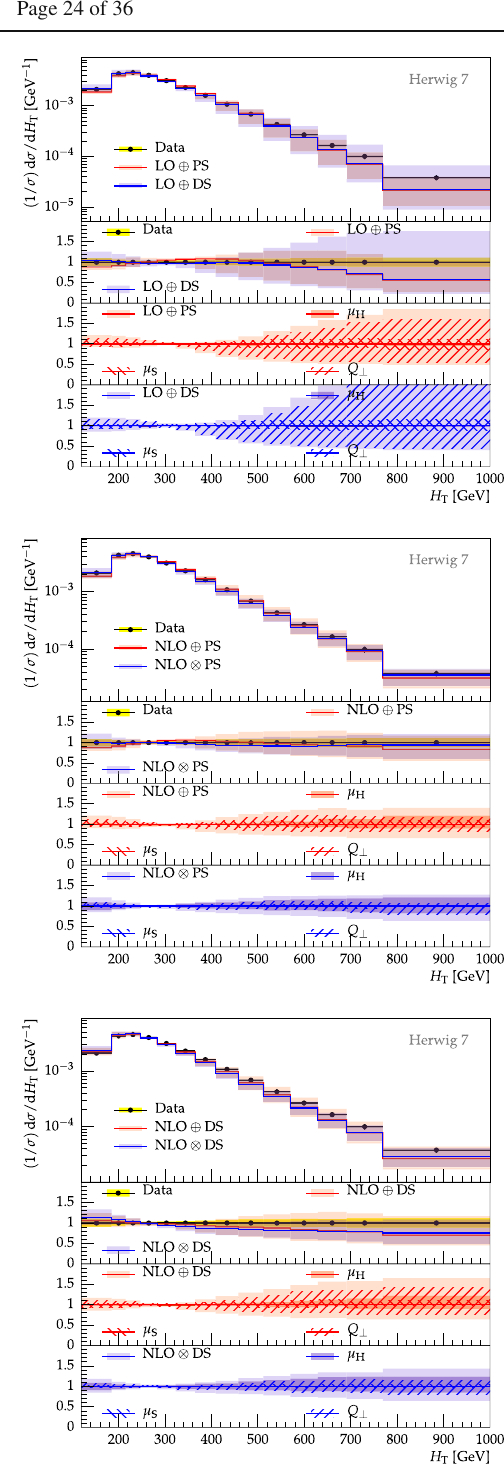
Fig. 11 The H T distribution measured in semileptonic 8TeV pp → t ¯ t events by CMS [65]. The theoretical predictions are the same as those described in the caption of Fig.